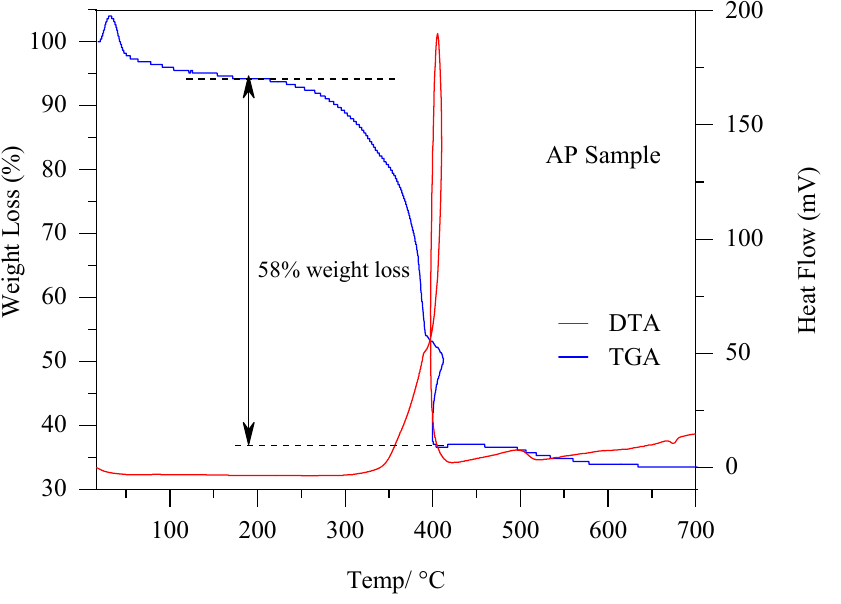
Figure 1. TG-DTA curves of the as-prepared V 2 O 5 sample with the layered crystal structure.